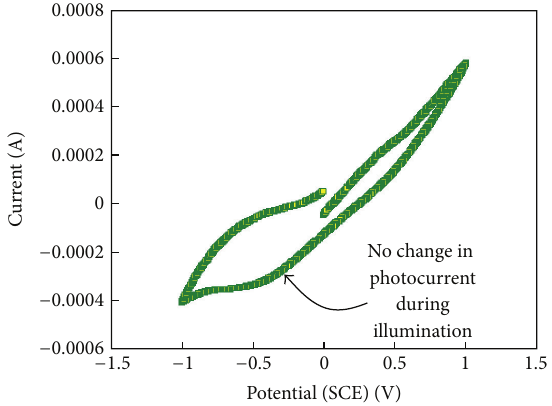
Figure 9: Current potential behavior of CZTS thin film grown on FTO coated glass and immersed in redox electrolytes containing Fe ( CN ) 63−/4− redox couple, during flashing light